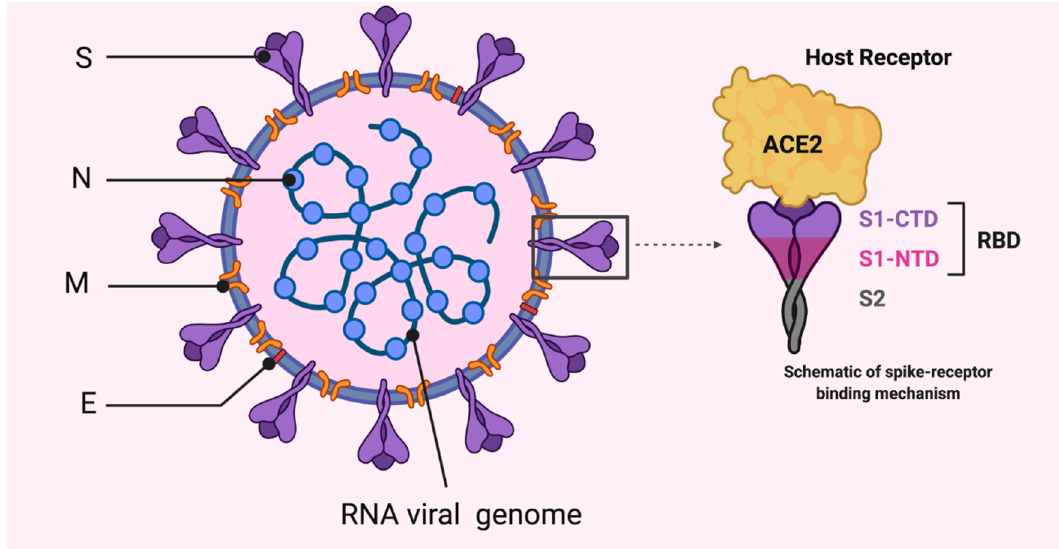
Figure 1. Coronavirus structure showing the organization of spike (S), membrane (M), and envelope (E) proteins. The viral RNA is associated with the nucleocapsid protein (N). ACE: angiotensin converting enzyme; RBD: receptor-binding domains; S1-NTD: N-terminal domain; S1-CTD: C-terminal domain; S1: amino termini; S2: carboxy termini.